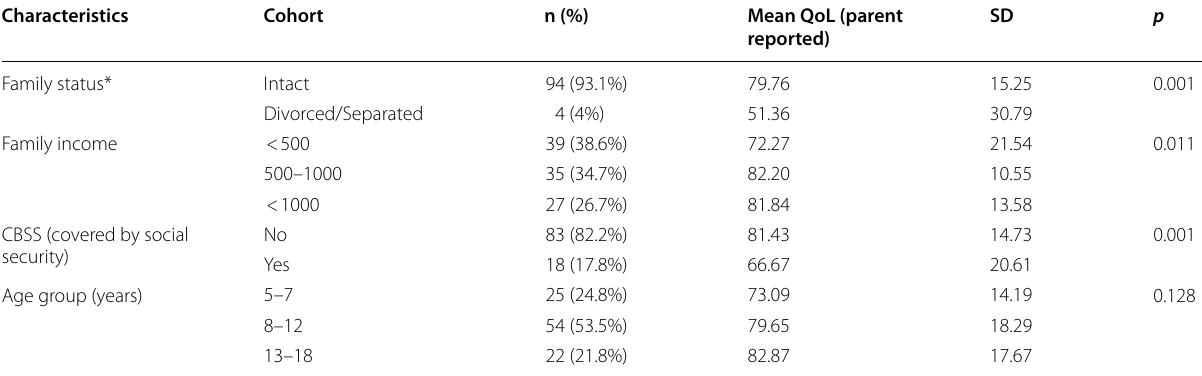
* Missing data was excluded from analysis